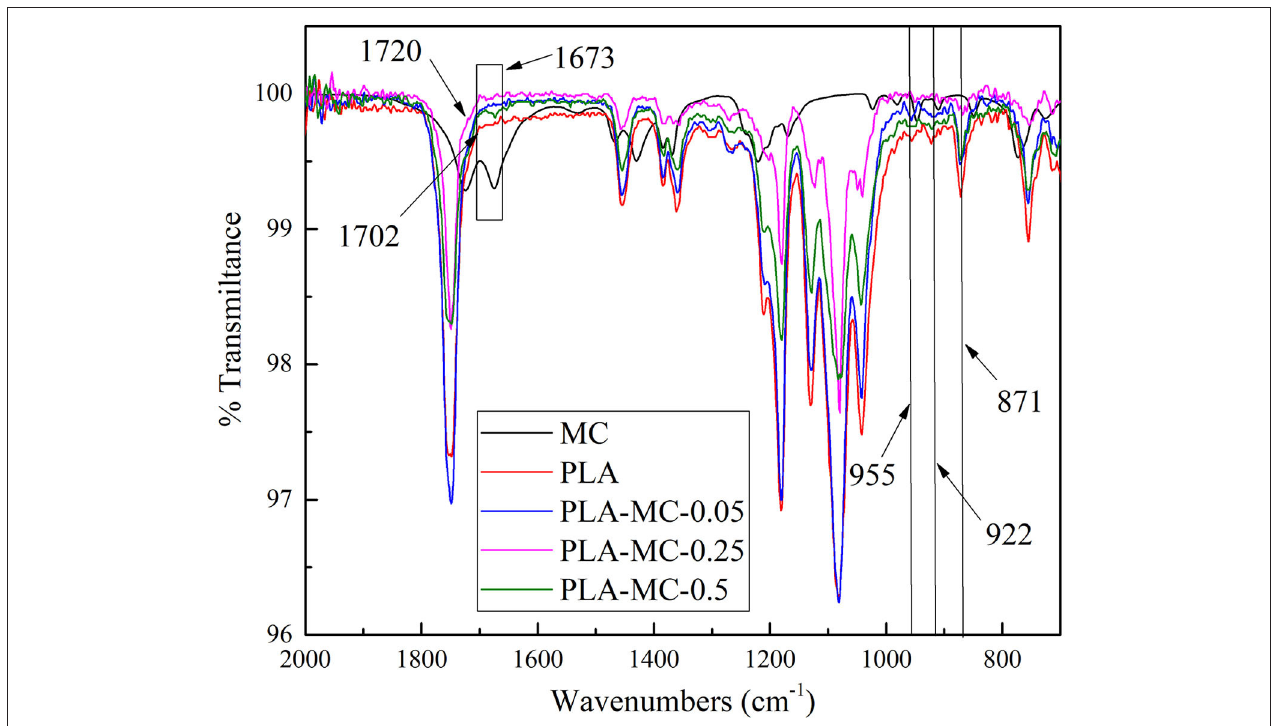
FIGURE 3 | FT–IR spectra of PLA film, PLA–MC-0.05 films, PLA–MC-0.25 and PLA–MC-0.5 films: magnification of the region of 2,000–700 cm − 1